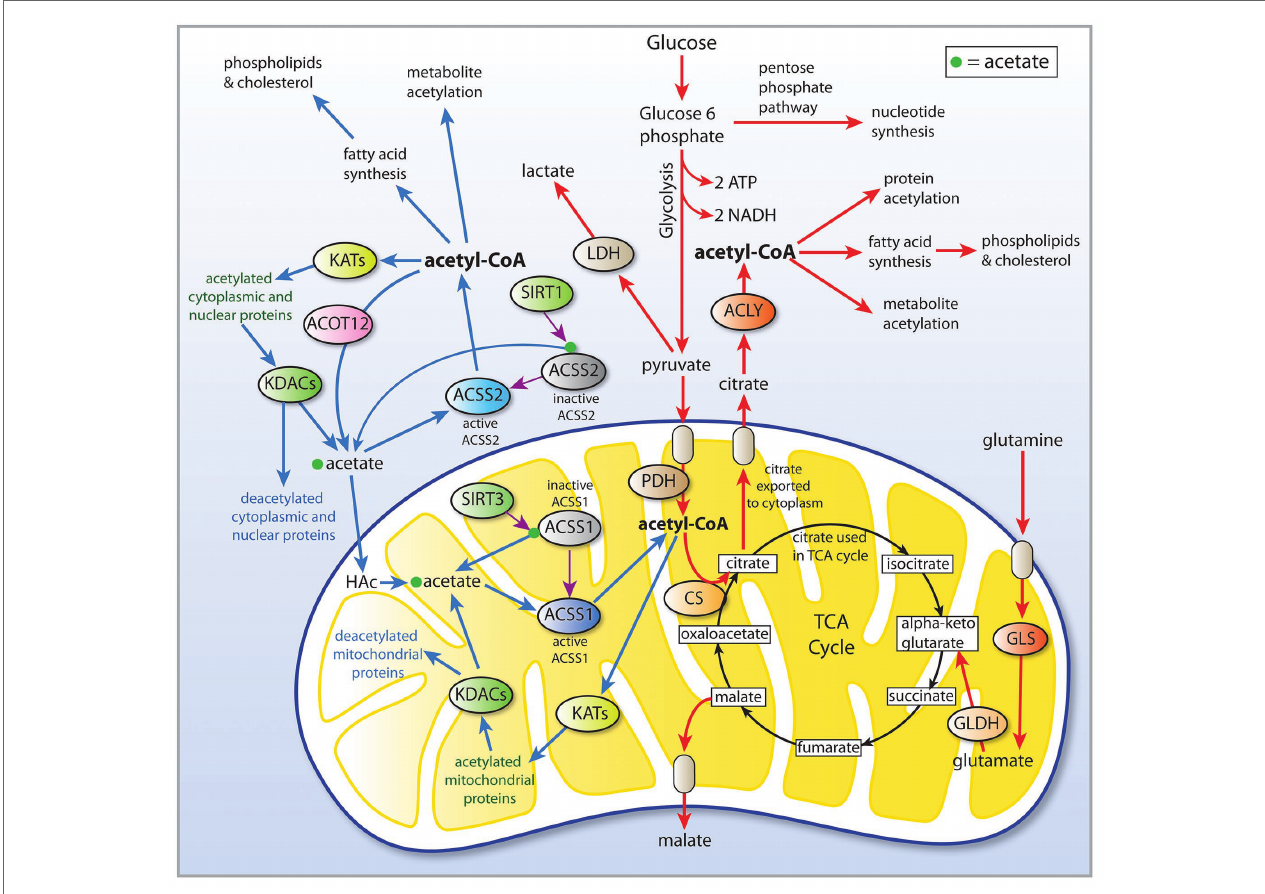
FIGURE 2 | Central carbon metabolism and links to ACSS function. Inputs to the TCA cycle come from numerous sources, including glucose, beta-oxidation of fatty acids, and metabolism of amino acids. Glucose is converted to pyruvate via glycolysis and the pyruvate then enters the TCA cycle after conversion to acetyl-CoA by the pyruvate dehydrogenase complex (PDH). The condensation of oxaloacetate with acetyl-CoA by citrate synthase (CS) generates citrate, which can either be oxidized to CO 2 in the cycle for energy derivation or the citrate can be exported to the cytoplasm. In the cytoplasm, citrate is reconverted to acetyl-CoA by ATP citrate lyase (ACLY). This generates the bulk of the cytoplasmic and nuclear pools of acetyl-CoA. The ACSS enzymes, in contrast, generate acetyl-CoA directly from free acetate in all cellular compartments. This provides cells with distinct routes to acetyl-CoA formation that can be regulated differentially. ACLY, ATP citrate lyase; ACOT12, acyl-CoA thioesterase 12; ACSS1, acyl-CoA short chain synthetase family member 1; ACSS2, acyl-CoA short chain synthetase family member 2; CS, citrate synthase; GLDH, glutamate dehydrogenase; GLS, glutaminase; KATs, lysine acetyltransferases; KDACs, lysine deacetylases; LDH, lactate dehydrogenase; SIRT1, sirtuin 1; and SIRT2, sirtuin